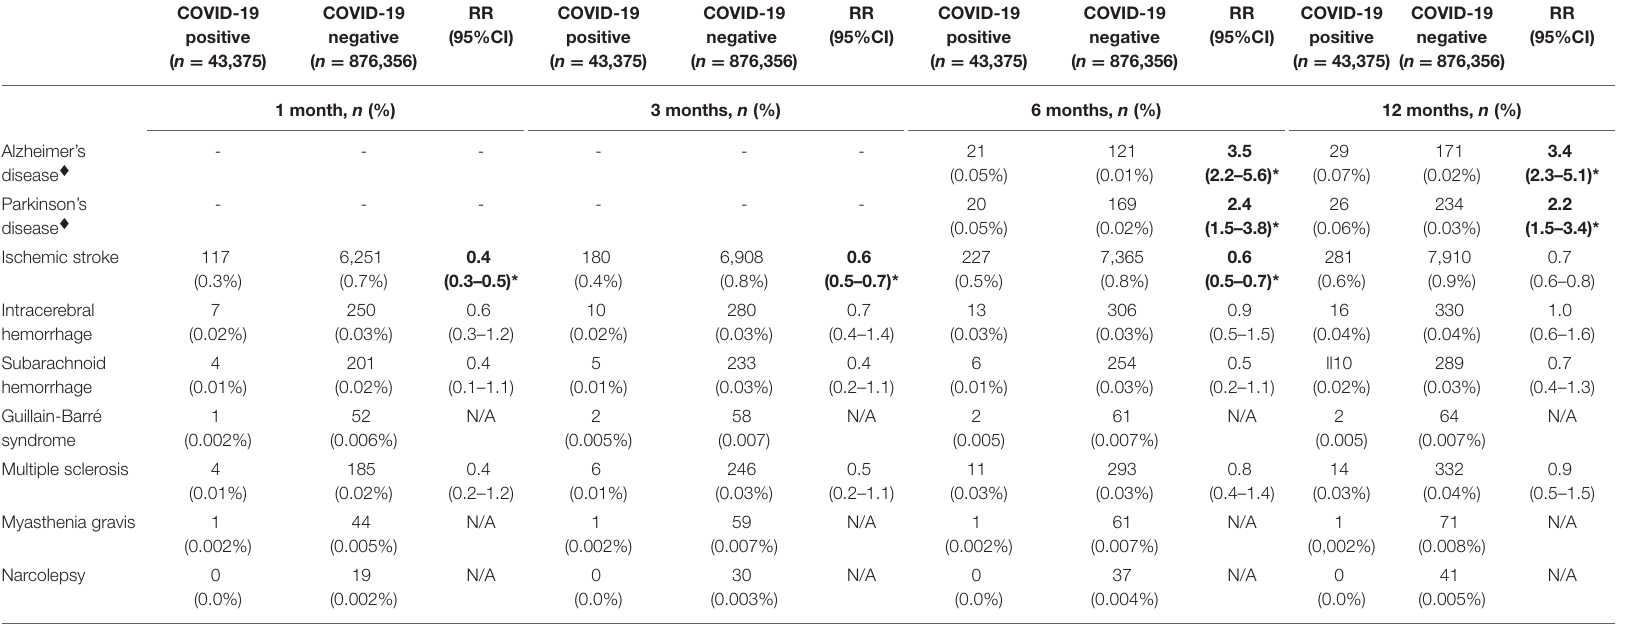
TABLE 2 | Relative risk of neurodegenerative, cerebrovascular and neuroimmune disorders in COVID-19 positive compared to COVID-negative